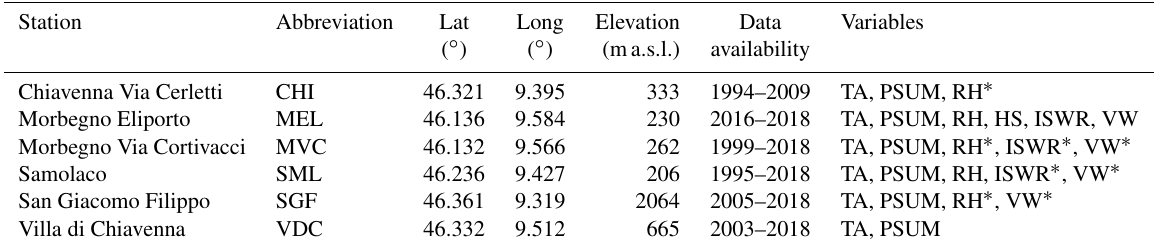
Table 3. Details about Italian meteorological stations (ARPA). The ∗ symbol next to some of the available variables indicates that such variables started to be recorded later than the first recorded year for TA and PSUM.